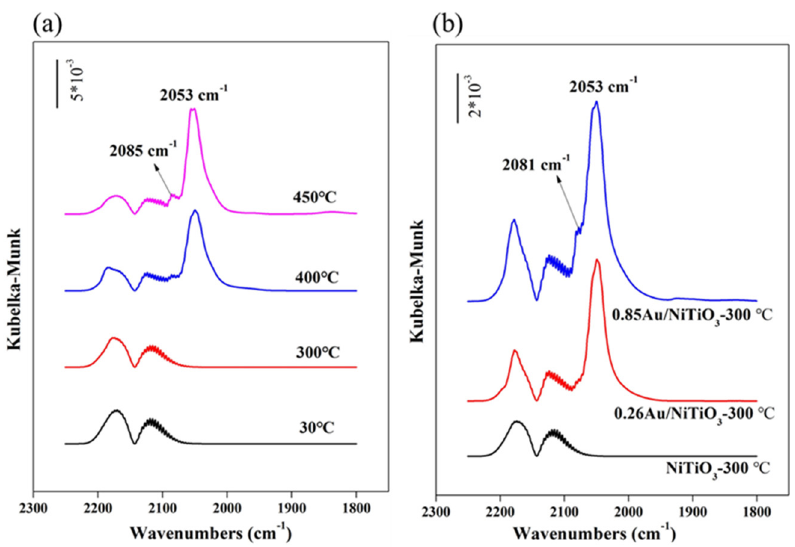
Figure 6. In situ DRIFT spectra of CO adsorptions taken at 30 °C over pre-treated NiTiO 3 at different temperatures ( a ) and pre-treated NiTiO 3 and Au/NiTiO 3 samples at 300 °C ( b ).